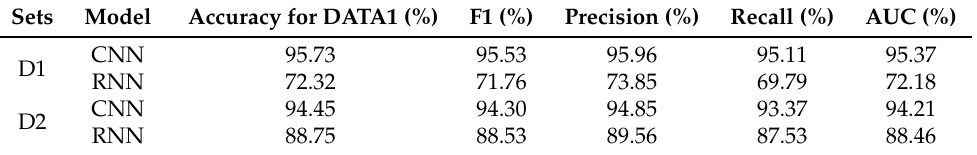
Figure 9. The structure of RNN. Table 6. Evaluation on D1, D2 with RNN and